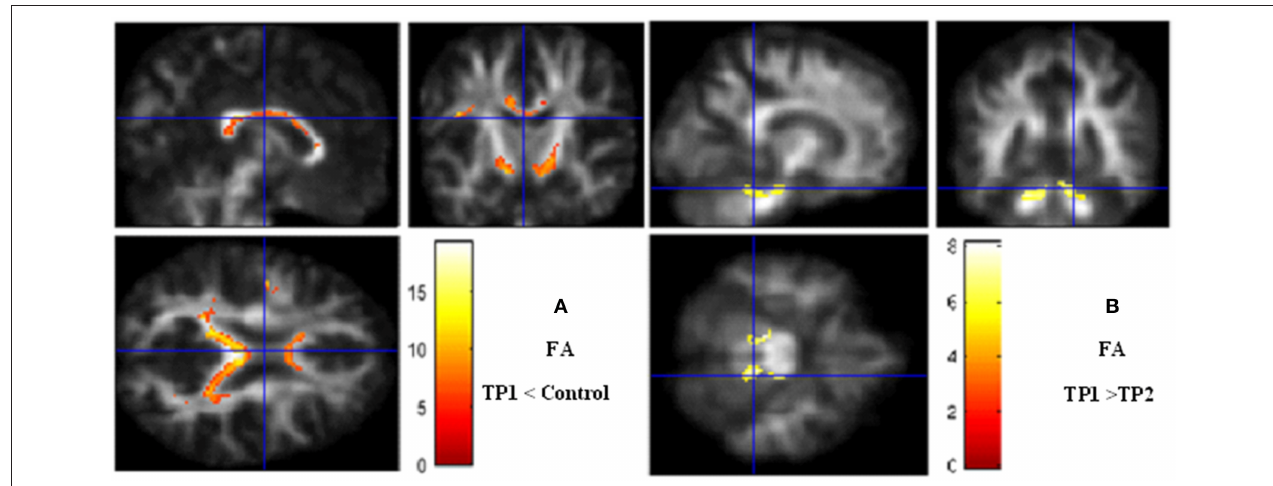
FIGURE 1 | Voxel-based analysis. (A) Fractional anisotropy decrease in TP1 (pretreatment) vs. controls. (B) Fractional anisotropy increases after bumetanide treatment. Significance maps (in red and yellow) overlaid on smooth anisotropy control image. The threshold was set at P < 0.05 (FEW Corrected) and minimum cluster size > 5 voxels. Color scale represents t -values. FA, fractional anisotropy; TP, Time Point.